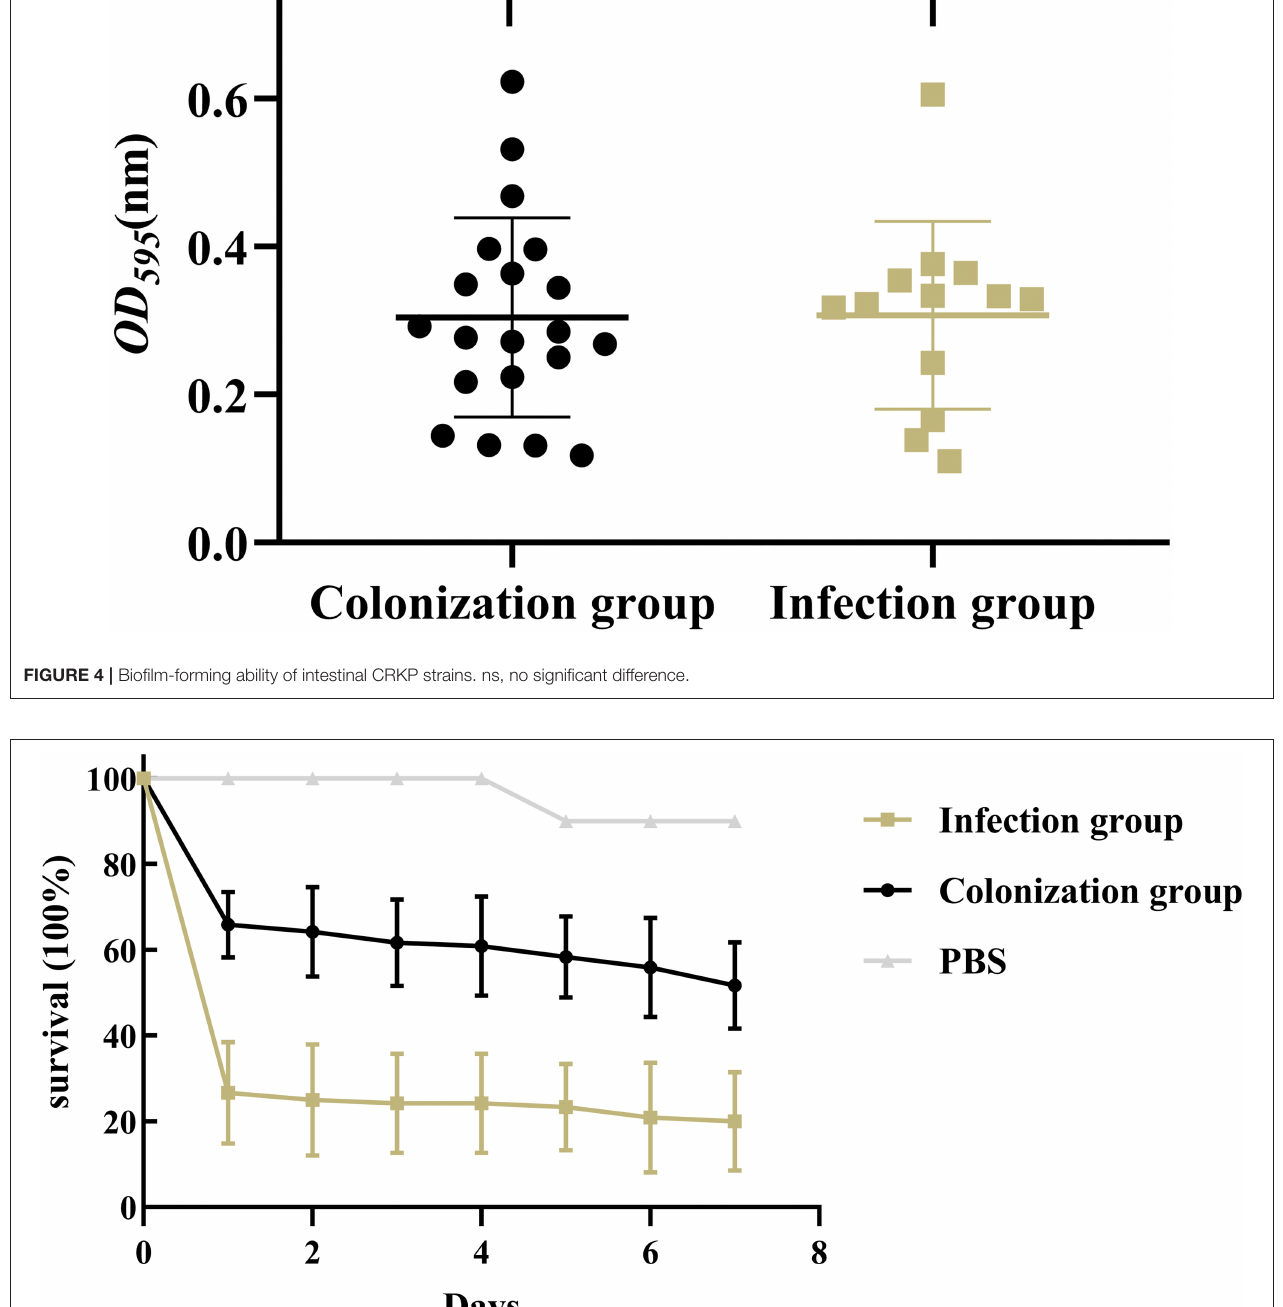
group. This may be closely related to the content of capsular polysaccharides in the strains. Studies have shown that capsular polysaccharides can hinder the reaction of bacteria with serum